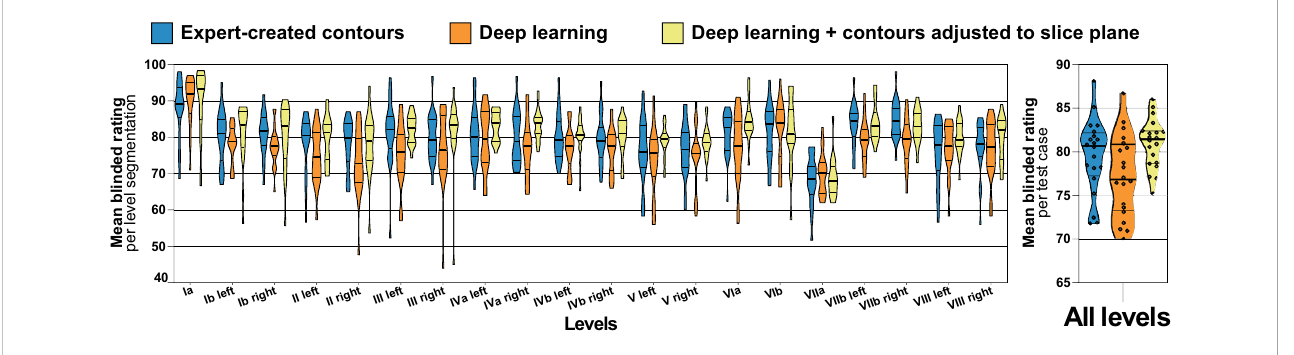
FIGURE 4 Blinded expert rating for expert-created level contours (blue) as well as for deep learning level autocontours without (orange) and with (yellow) the CT slice plane adjustment postprocessing applied (test set n = 20). The left graph shows blinded expert ratings for each level separately and the right graph shows mean ratings per test case across all levels. Improved blinded expert rating with as compared to without slice plane adjustment postprocessing. Violin plots, thick horizontal lines: median, thin horizontal lines: quartiles, rhombi: individual data